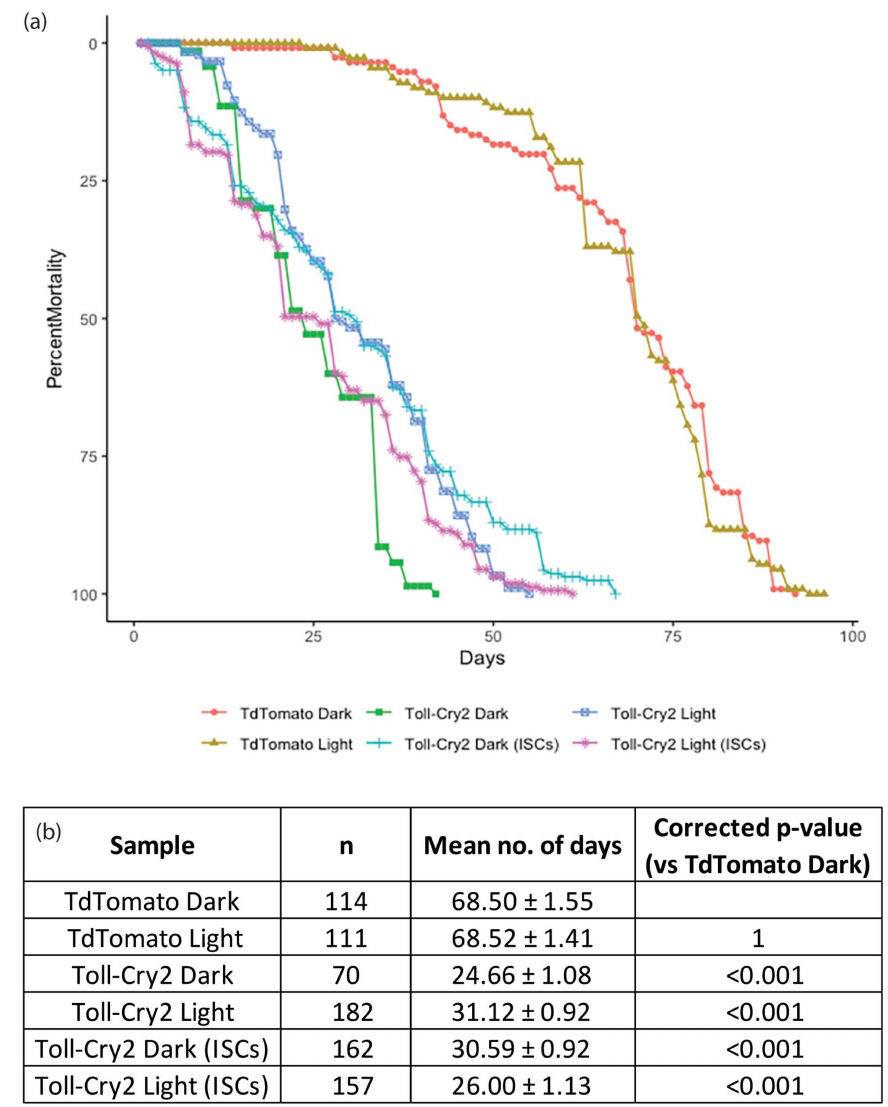
Figure 6. Activated Toll reduces lifespan. Lifespan analysis of TdTomato (control) dark and light, Toll-Cry2-mCh dark and light in the whole fly, Toll-Cry2-mCh dark and light expression in the ISCs only. Genotype: TdTomato—Arm-Gal4 > UAS-Td-Tomato; Toll-Cry2—ArmGal4 > UAS-Toll-Cry2- mCh; Toll-Cry2 (ISCs)—esg-Gal4 > UAS-GFP, UAS-Toll-Cry2-mCh. ( a ) The lifespan curves for the various genotypes, and ( b ) table showing the number of subjects with mean lifespans and p -values. Raw data provided in Supplemental Table